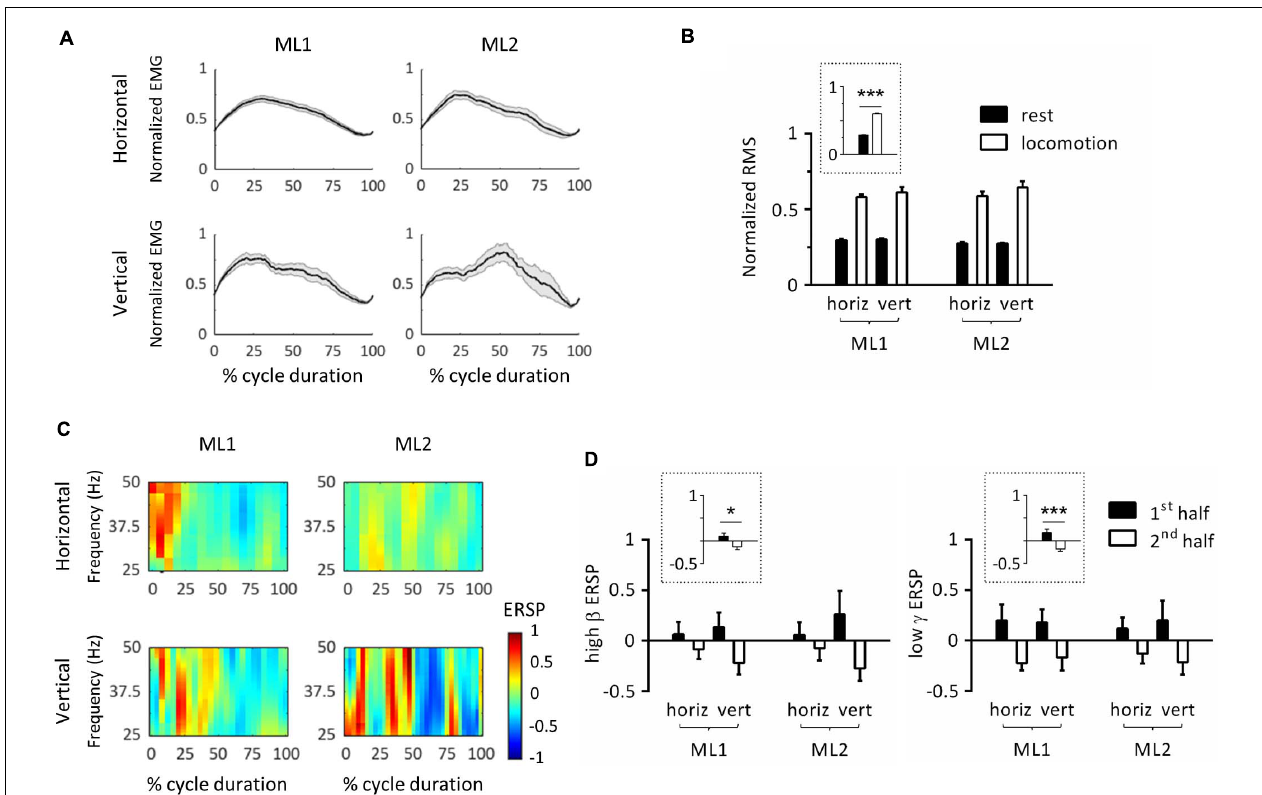
FIGURE 3 | Event-related spectral perturbations (ERSPs) in left primary motor cortex during locomotor cycles. (A) Time-course of electromyographic (EMG) activity of the right triceps muscle during locomotor cycles. For each animal, EMG was normalized by maximum root-mean-square (RMS). In this panel, cycle duration was normalized by time-warping individual cycles to median cycle length. The black line represents the average across cycles, and the gray zone, one standard error of the mean. (B) RMS of triceps EMG activity across animals, substrate orientations and epochs. For each animal, RMS was normalized by its maximum value. The plot surrounded by a dot line emphasizes epoch-related differences in RMS averaged across animals and orientations. (C) ERSP plots showing average changes in spectral power relative to full gait cycle. In this panel, cycle duration was normalized by time-warping individual cycles to median cycle length. (D) Average ERSP in high β (left panel) and low γ (right panel) bands across animals, substrate orientations and epochs. Plots surrounded by a dot line emphasize epoch-related differences in ERSP averaged across animals and orientations. * p < 0.05 and *** p < 0.001, main effect of epoch as revealed by three-way ANOVA with aligned-rank transform (factors: animal, orientation, and epoch). All measurements are expressed as mean ± standard error of the mean (SEM). horiz, horizontal; vert, vertical. 1st half and 2nd half refer to the corresponding period of locomotor cycles.